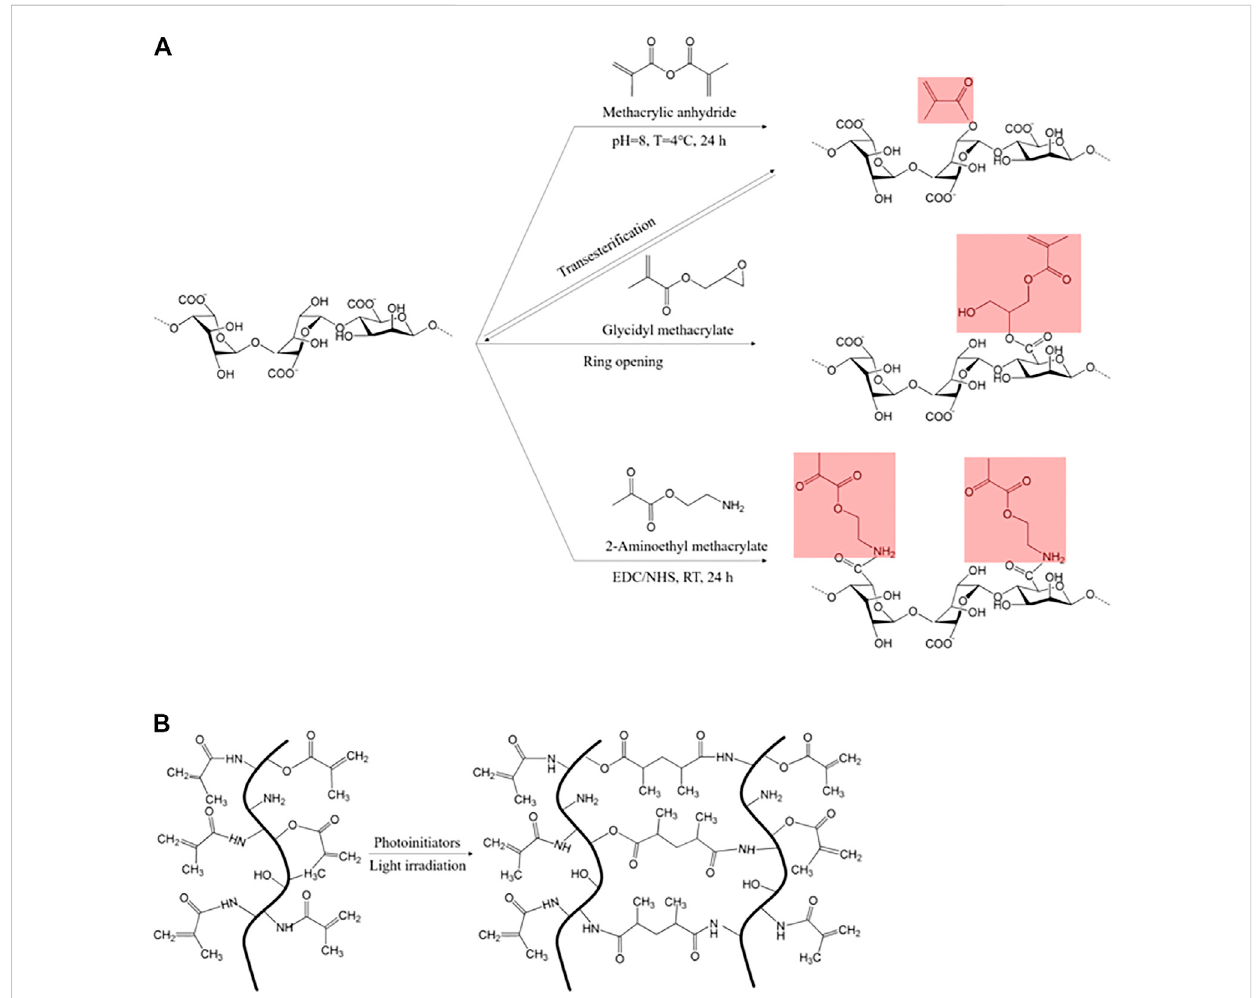
FIGURE 2 (A) Diverse methacryloyl substitution in methacrylic alginate induced by methacrylic anhydride, glycidyl methacrylate, and 2-aminoethyl methacrylate (Hasany et al., 2021), and (B) light-activated chain polymerization that occurred between two methacryloyl moieties (red: photo-reactive residues) (Bupphathong et al.,